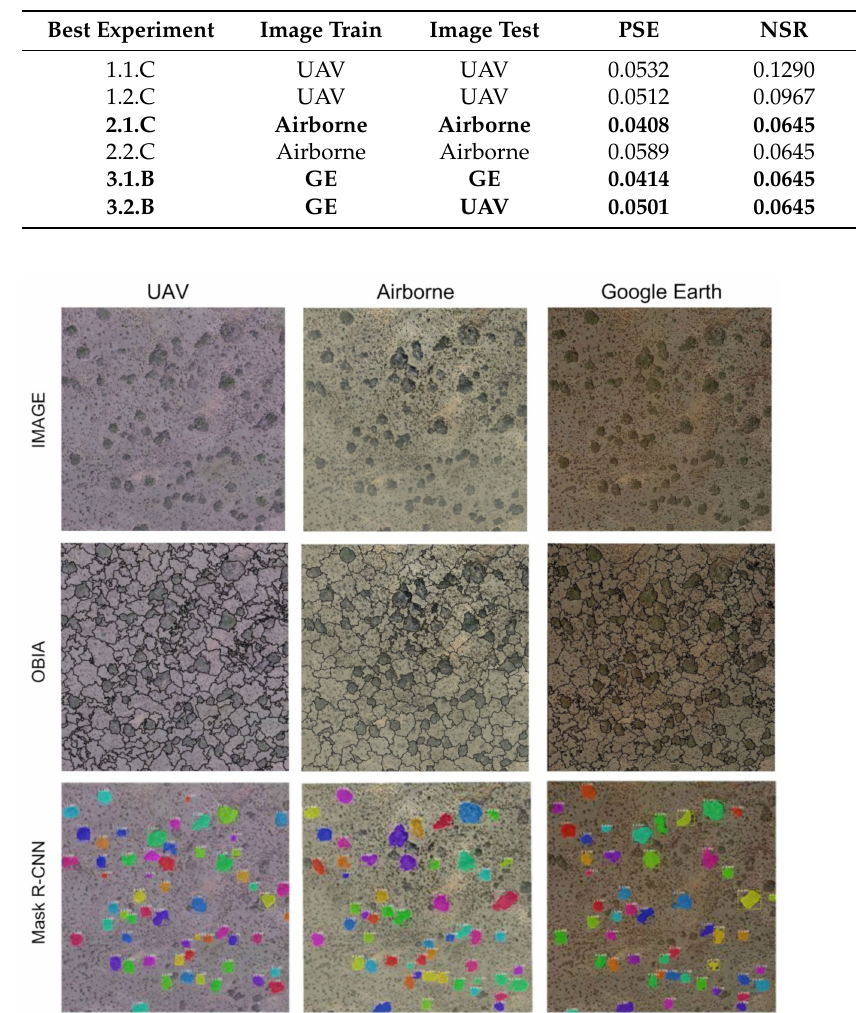
Table 3. Segmentation accuracies of Mask Region-based Convolutional Neural Networks (Mask R-CNN). PSE: Potential Segmentation Error; NSR: Number Segmentation Ratio; ED2: Euclidean Distance v.2. In bold the most accurate results.